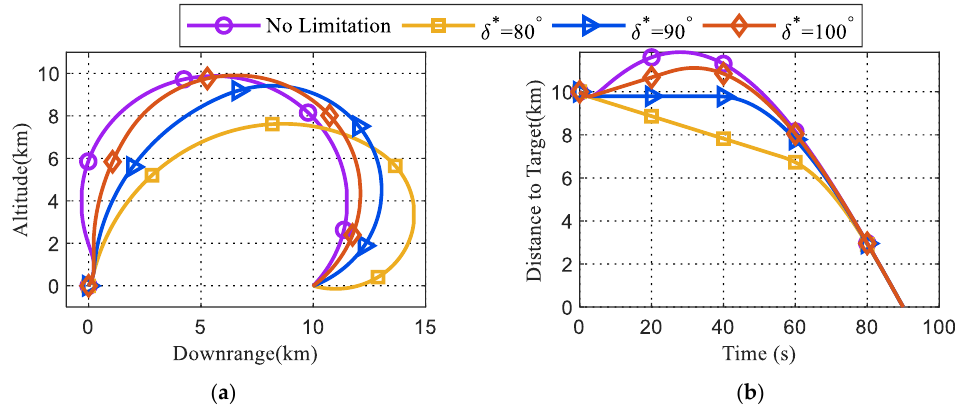
Figure 8. The results with different constraints on look angle. ( a ) Trajectories; ( b ) Distance-to-go.